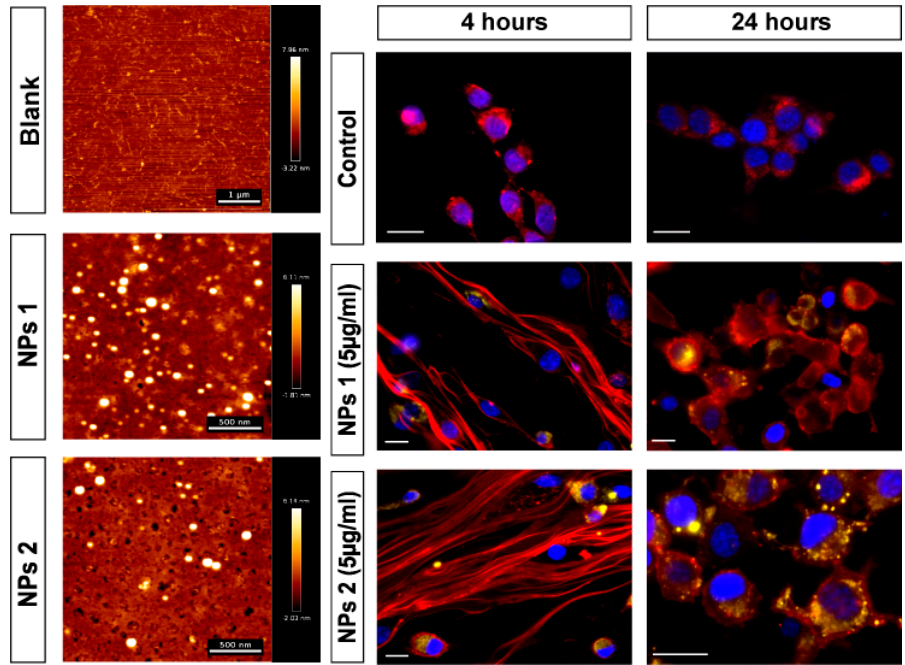
Figure 1. Representative AFM images of blank glass, NPs 1 and NPs 2 in alternating contact (AC) mode in air (scale bar = 500 µ m) are showed in the left column of the panel. Fluorescence images in the right columns of the panel show the internalization of NPs by CT-26 cells. The nanoparticles (yellow) were detected in all treated groups and time points. Scale bar: 20 µ m.